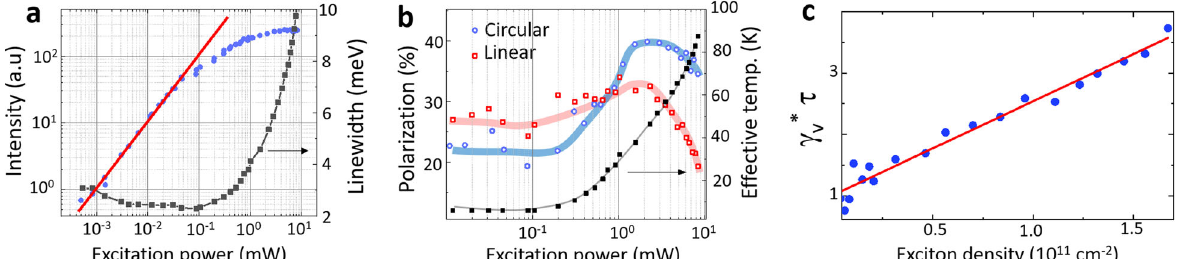
Fig. 3 Spatially averaged valley polarization and coherence at high excitation densities. T = 6 K. a Integrated PL intensity (blue dots) as a function of the laser excitation power. The red line represents a linear relationship between intensity and excitation power. The exciton linewidth is shown in black squares. b Degree of polarization as a function of the laser excitation power. Also shown is the effective temperature extracted from the linewidth of the neutral exciton peak. The continuous lines are a guide to the eye. c Extracted γ (cid:3) v τ product as a function of the exciton density, where τ is the exciton lifetime and γ (cid:3) v the pure dephasing rate of valley